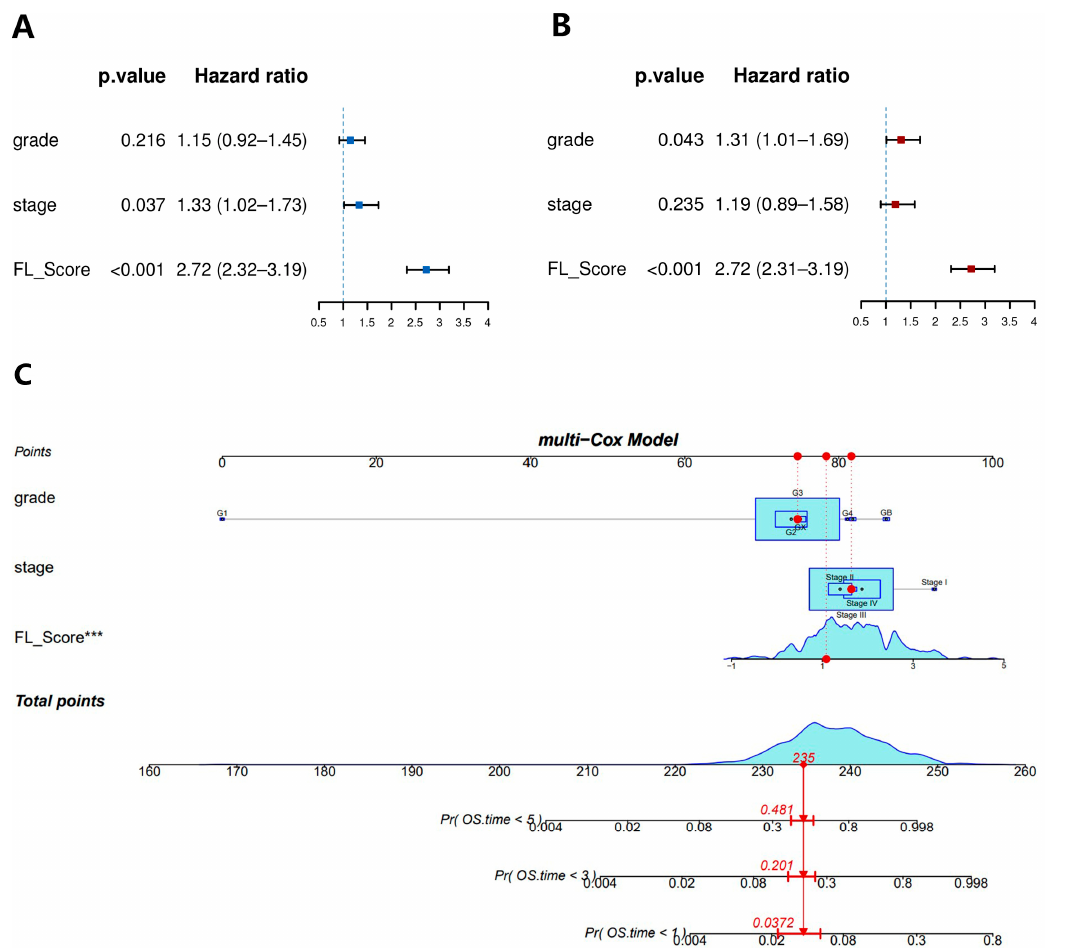
Figure 5. Comparisons between the ferroptosis-related lncRNA score (FL_score) signature and other models [9,10,28–42]. The 1-, 3-, and 5-year area under the curve (AUC) values of the FL_score signature (red column) and other models (gray column) developed in The Cancer Genome Atlas (TCGA) ovarian cancer cohort.